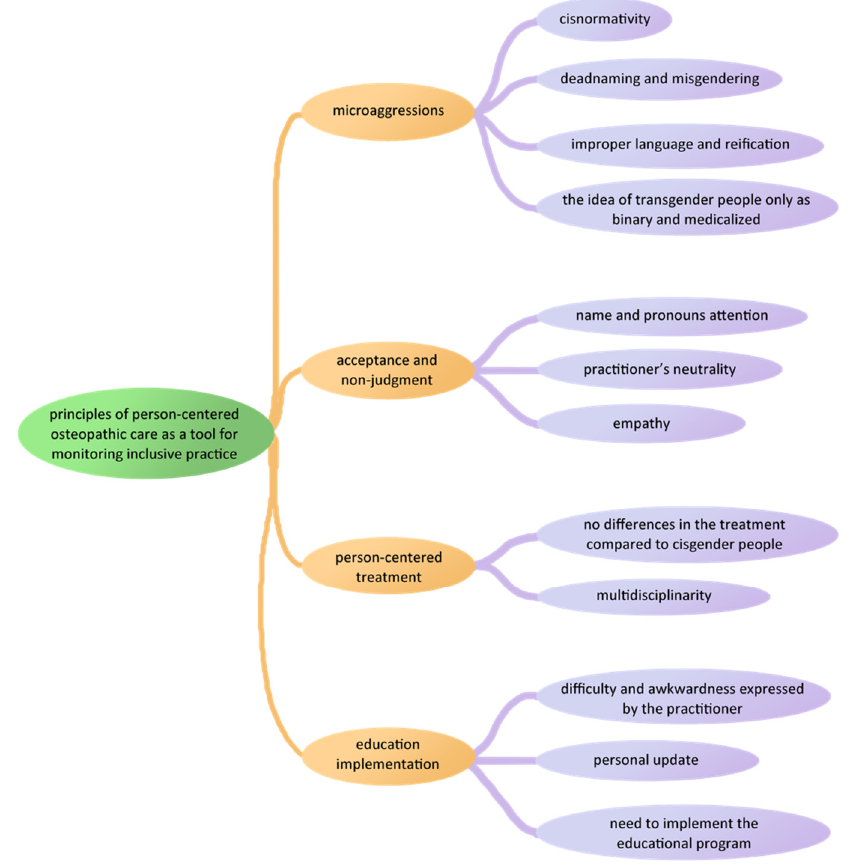
Figure 2. Osteopaths’ attitudes toward transgender patients: a thematic map. Table 3. Cisnormativity.